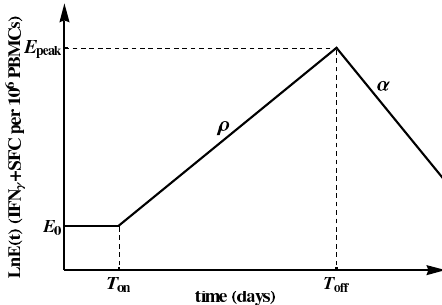
Figure 1. Schematic representation of the T on / T off mathematical model fitted to the epitope-specific CD8 + T-cell response kinetics data [86]. In this model, E 0 epitope-specific naive CD8 + T cells become activated at time t = T on and start proliferating at rate ρ . At t = T off , T-cell response peaks and declines at rate α . We refer to E 0 as the predicted initial frequency of epitope-specific CD8 + T cells [87]. Evidently, E 0 may over- or under-estimate the response precursor frequency depending on exactly when the T cells became activated and how adequate the mathematical model is for describing immune response data during the expansion